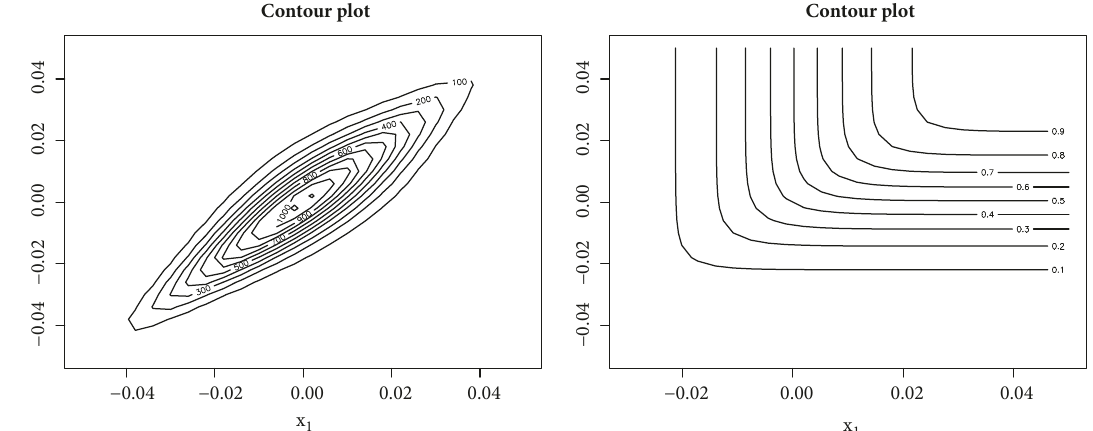
Figure 4: Density and cumulative distribution contour plots of distribution having MEGB2